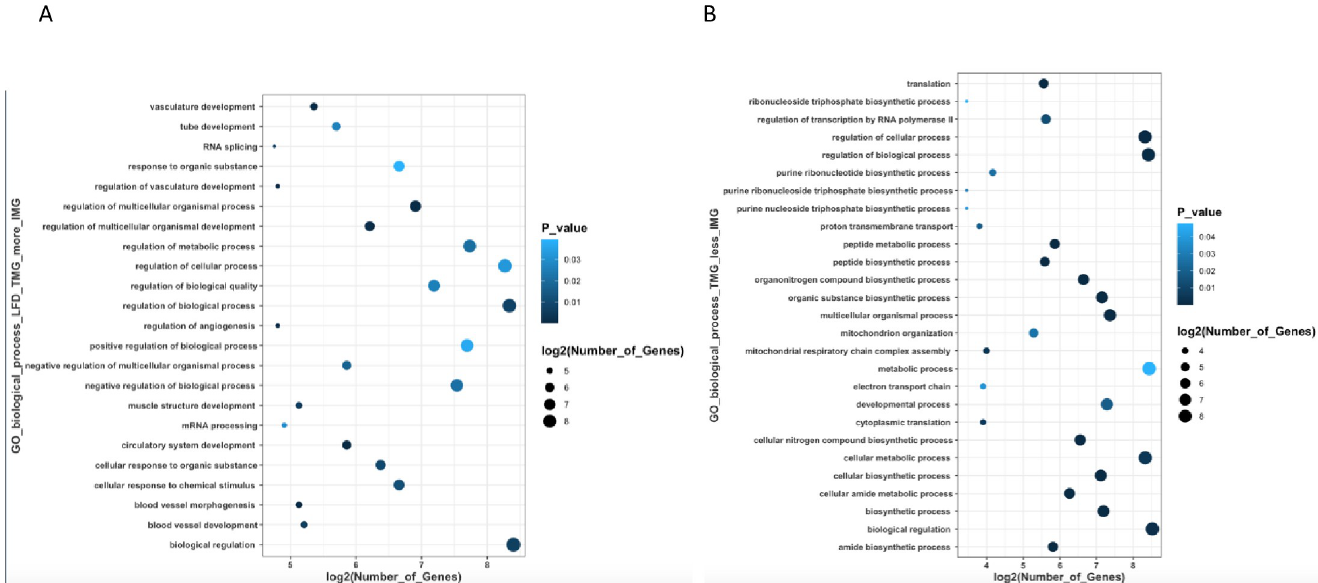
Fig 2. Summary of GO Biological Processes that are most upregulated (A) in the thoracic mammary gland and downregulated (B) in the TMG in dams fed a LFD .